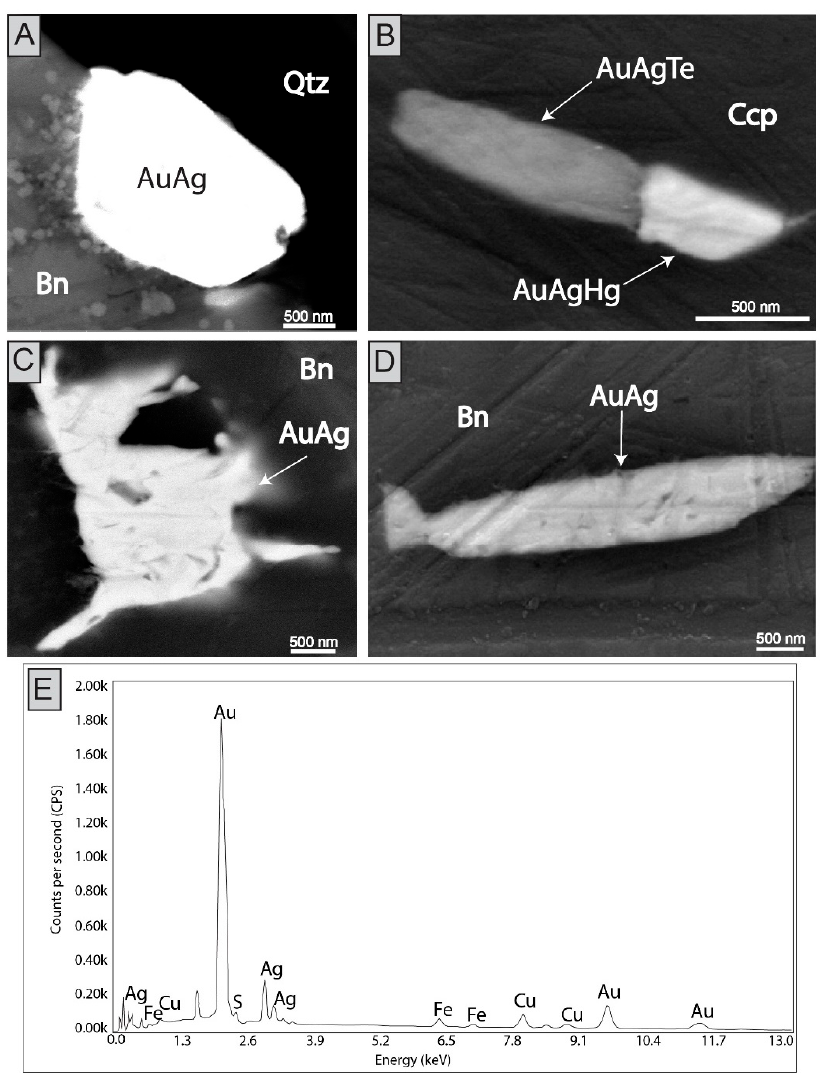
Figure 3. Field-emission scanning electron microscopy (FESEM) images of silver, gold, mercury, and tellurium mineral inclusions in chalcopyrite and bornite from Río Blanco. Electrum (Au,Ag) grains are shown images ( A – D ). Au–Ag–Te and Au–Ag–Hg phases are shown in ( B ). Images ( A , C ) were taken using the back-scattered electron (BSE) detector, while images ( B , D ) were taken using a secondary electron (SE) detector. ( E ) shows the EDS spectrum of the electrum grain shown in ( A ). Ccp: chalcopyrite, Bn: bornite, Qtz: quartz, AuAg: electrum, AuAgTe: possibly sylvanite or petzite.